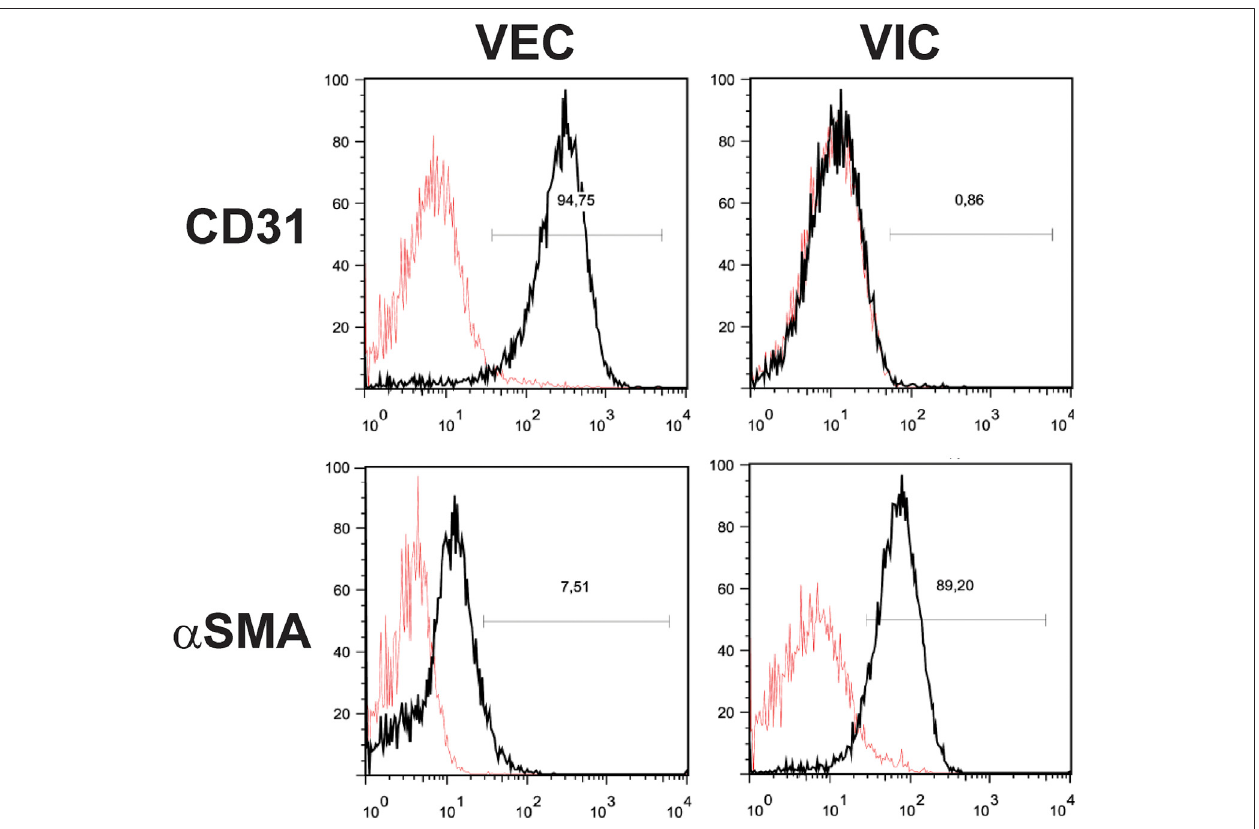
FIGURE 4 | Fluorescence-activated cell sorting (FACS) analysis of valve endothelial (VEC) and interstitial cells (VIC). Cells were isolated from aortic valves with calci fi cation (n = 3). A representative image shows expression of the typical fi broblastic marker protein alpha-smooth muscle actin ( α SMA) in VIC, but not in VEC and expression of typical endothelial cell marker CD31 in VEC, but not in